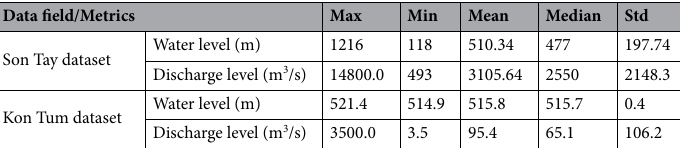
Table 1. Detailed statistics of the two datasets.